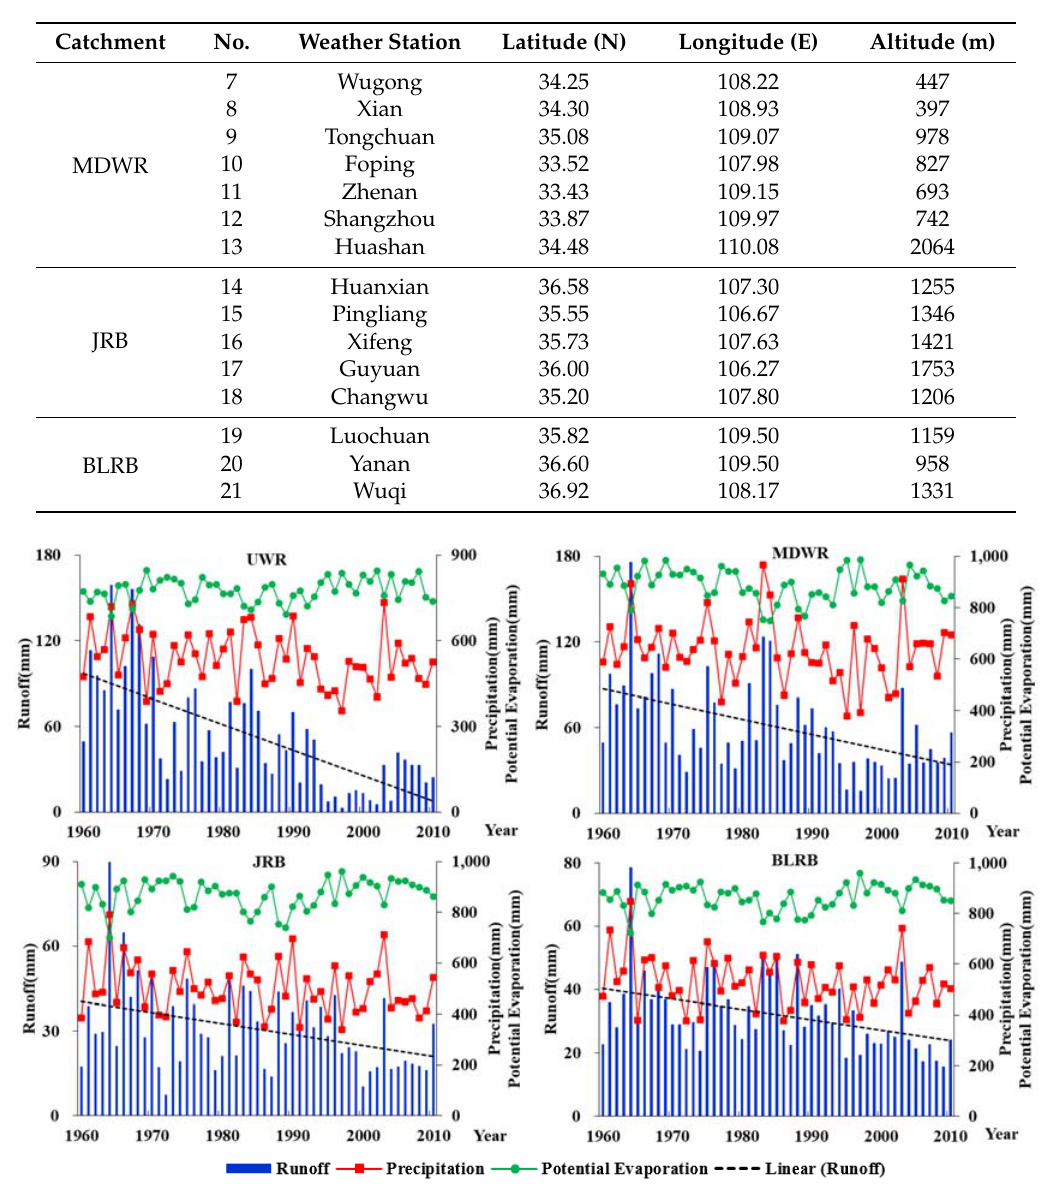
Figure 2. Annual precipitation, potential evaporation, and runoff of the four sub-catchments in the Wei River Basin (WRB).